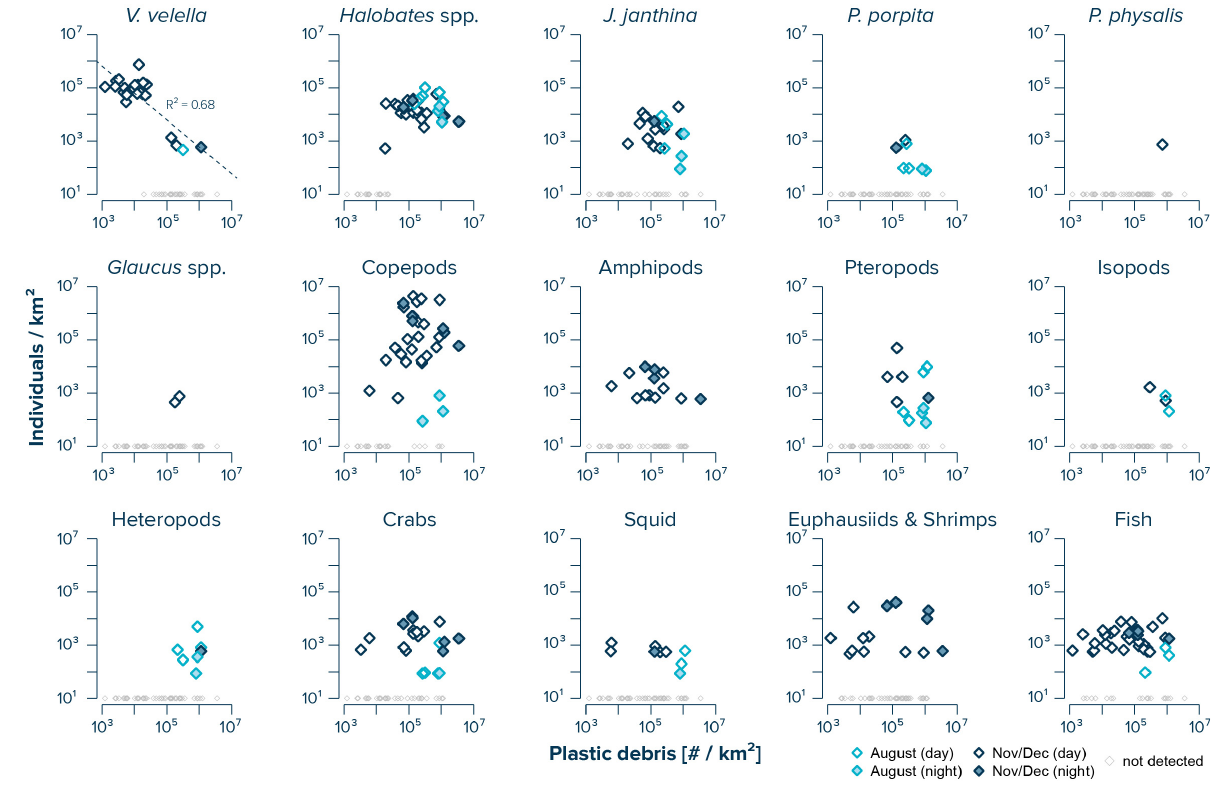
FIGURE 3 | Log–log correlations of measured (uncorrected) concentrations of floating plastic debris (0.05–5 cm in size) and observed numbers of individuals per species. Dark blue diamonds represent samples taken during the NPM3 Expedition in November/December 2019, while light blue diamonds are samples collected during the Mega Expedition in August 2015. Filled diamonds indicates sampling after sunset. Small gray diamonds represent Manta trawls samples where no individuals of the corresponding species were observed. Note that the average limit of detection was 611 individuals/km 2 during the NPM3 Expedition and 114 individuals/km 2 during the Mega